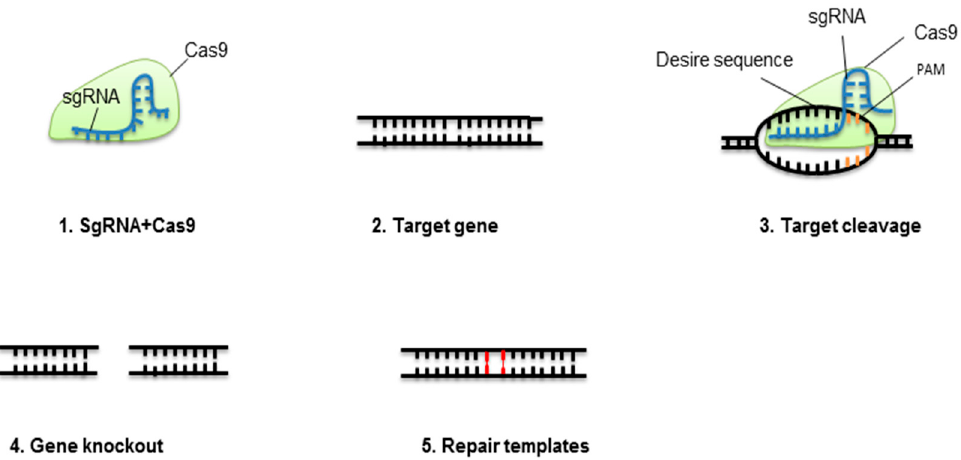
Figure 1. Concept of CRISPR-Cas9-mediated gene elimination. Single guide RNA (sgRNA) containing crRNA and tracrRNA fixes to Cas9 protein. This complex will break at a specific target of the double-stranded DNA molecule. The nonhomologous end-joining pathway (NHEJ) will repair the cleaved location.